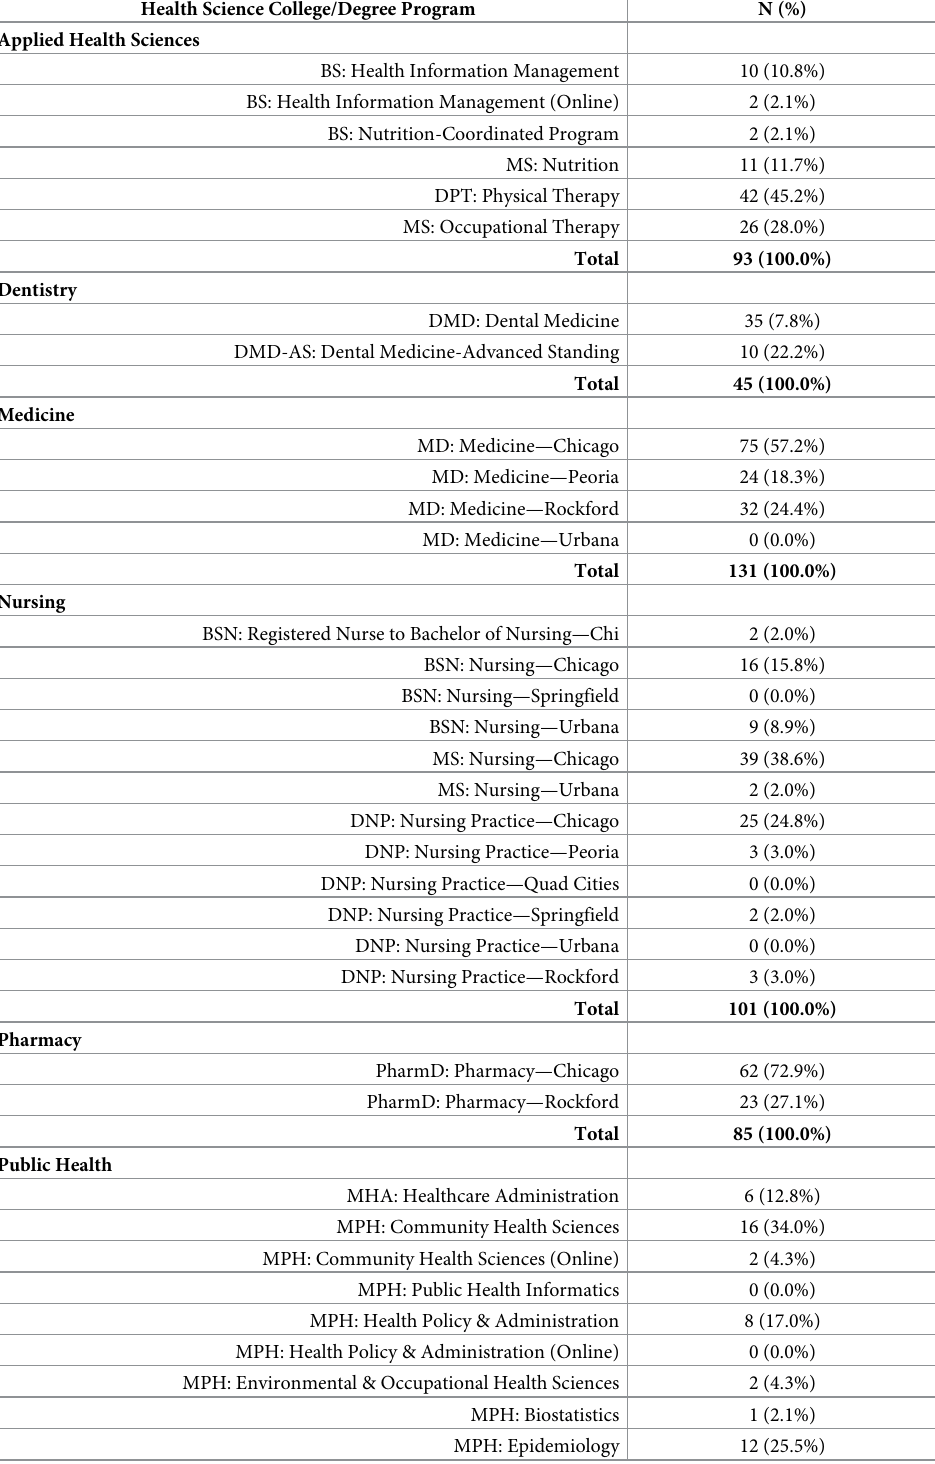
Table 4. Degree programs among HOLISTIC Cohort Study participants enrolled as of May 5, 2021 (after first of three recruitment